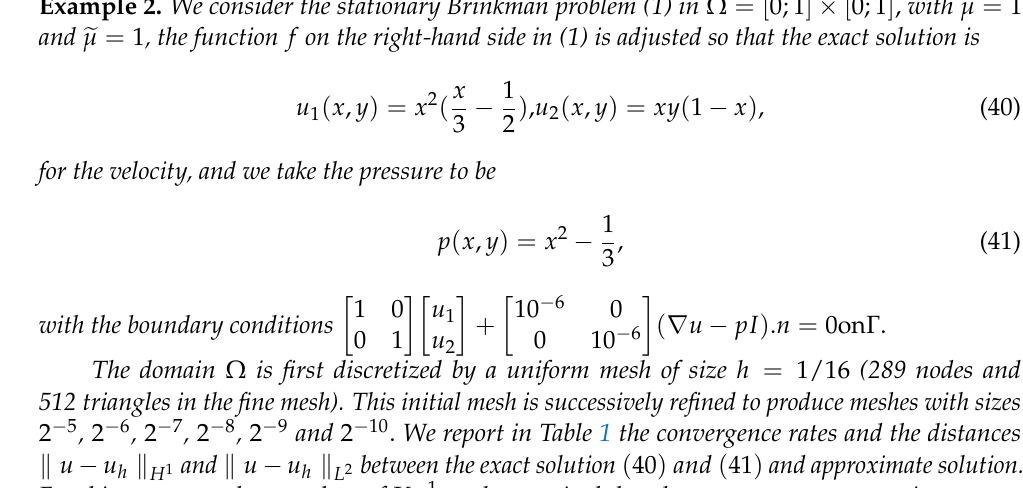
𝛼𝛼 1 = 10 𝛼𝛼 2 = 1. In the previous example, the two-dimensional flow past a circular cylinder was simulated for